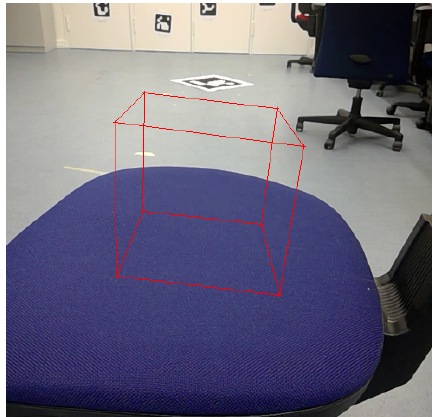
Figure 8. Augmentation of the video stream of the tablet rear-side camera with a virtual wireframe